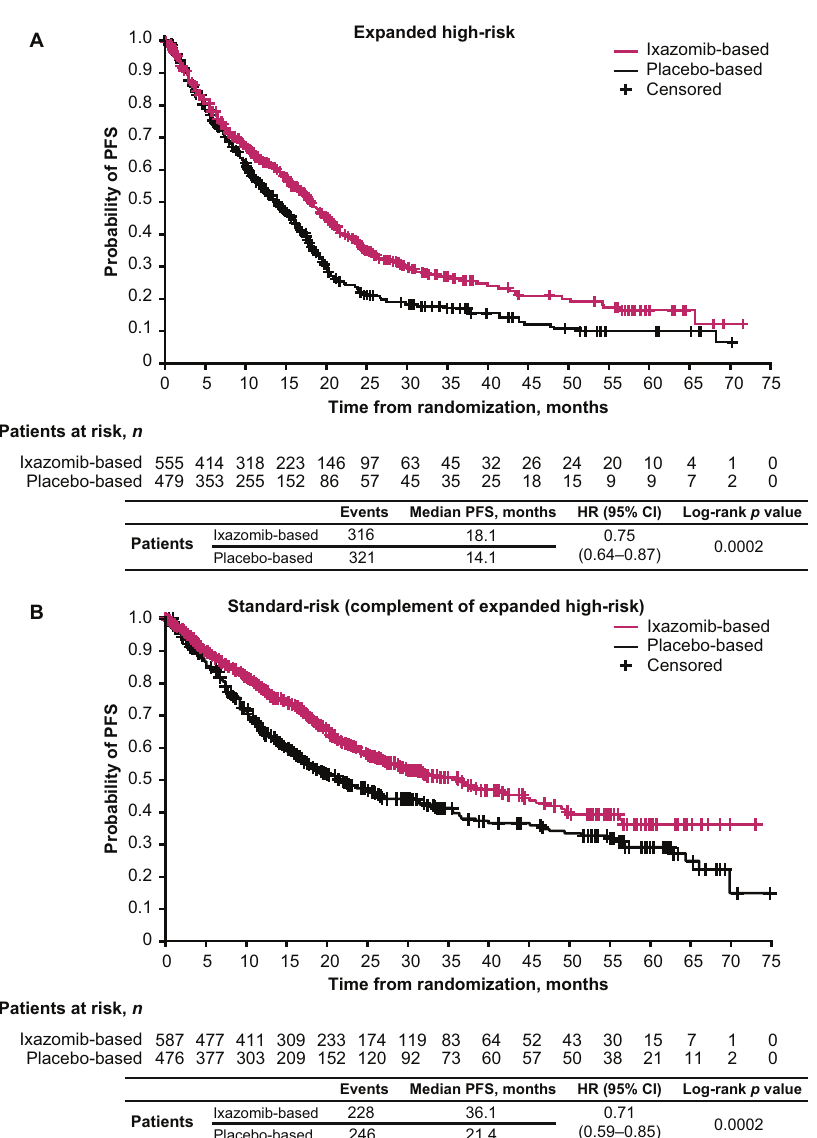
Fig. 3 Kaplan – Meier estimates of PFS for patients with expanded high- or standard-risk cytogenetic abnormalities receiving ixazomib- vs placebo-based therapy. A Expanded high-risk cytogenetic abnormalities, and B standard-risk (complement of expanded high-risk) abnormalities. CI con fi dence interval, HR hazard ratio, PFS progression-free